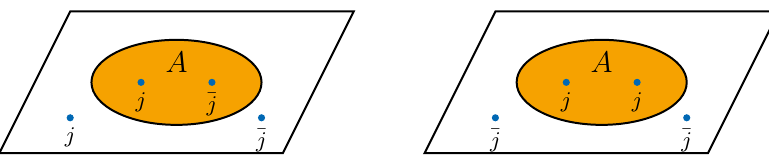
Figure 12 . The spherical entangling region with two excitations inside and the other two outside. There are two configurations: (1) two excitations in A are in the same representation [Left], (2) two excitations in A are in the conjugate representation to each other [Right].